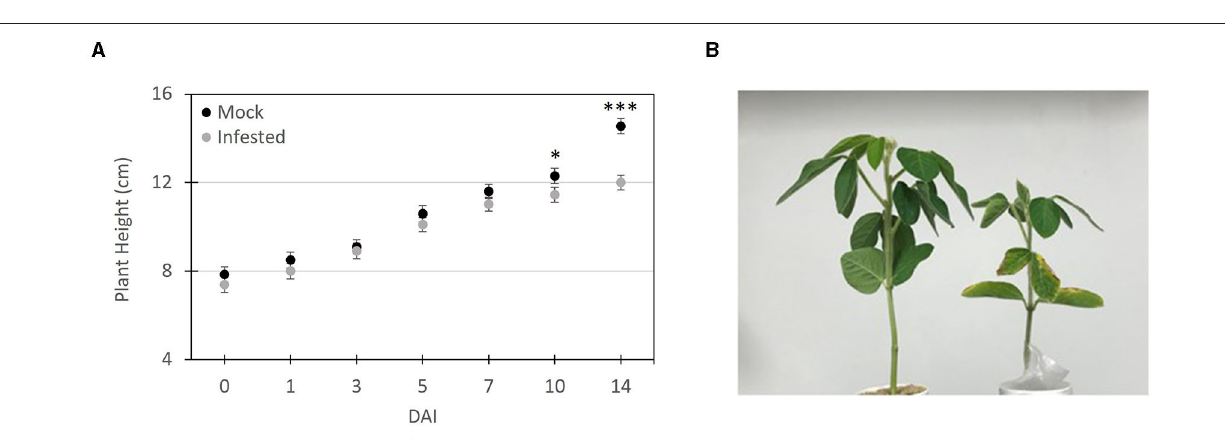
and β -Pinene (CPV24). Butylated Hydroxytoluene